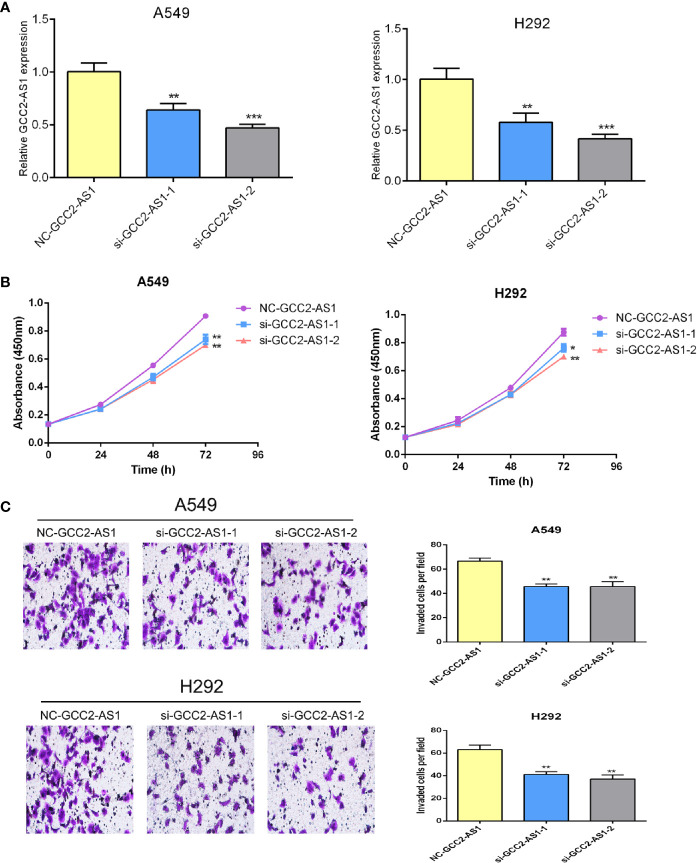
Effects of GCC2-AS1 on lung adenocarcinoma cells. (A) Relative expression of GCC2-AS1 in A549 and H292 cells transfected with GCC2-AS1 siRNA and negative control. (B) CCK8 assays was performed to detected the proliferation rate. (C) Transwell assays were assessed the invasive ability of each group. Scale bar, 20 μm. Data are presented as the mean ± SD of three independent experiments (**P < 0.01; ***P < 0.001).